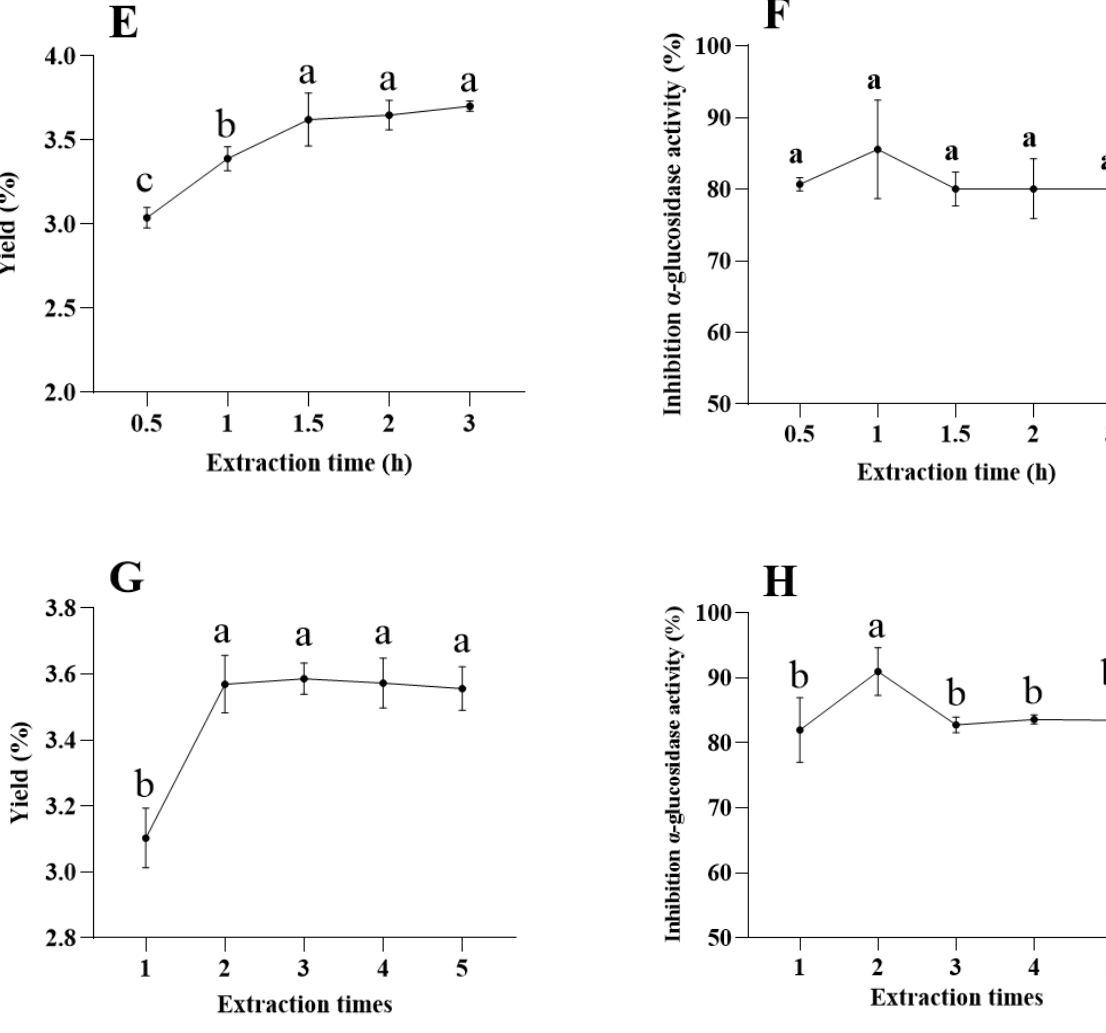
Figure 1. Effects of different extraction temperatures ( A , B ), solid-liquid ratios ( C , D ), time ( E , F ) and number of extraction times ( G , H ) on the yield of MAP-2 and inhibition of α -glucosidase activity. Each experiment was repeated three times; the error bars are standard deviations; significant ( p < 0.05) differences are shown by data bearing different letters (a–c); statistical significances were carried out by ANOVA and Duncan’s test.